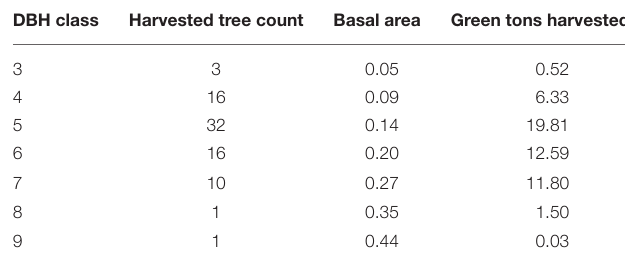
TABLE 2 | Summary data for the 10 × 6 harvested stand